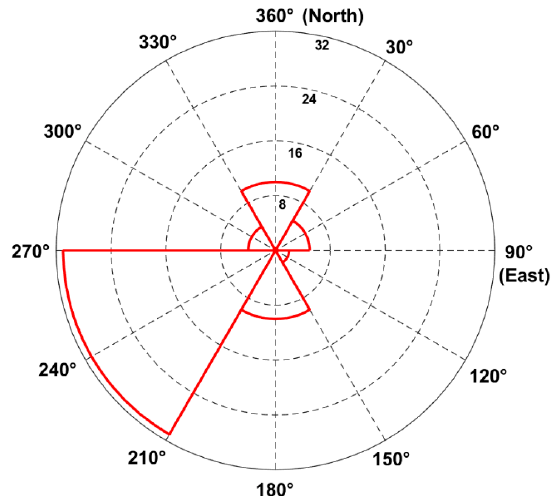
Figure 5. The distribution of wind directions of the images.